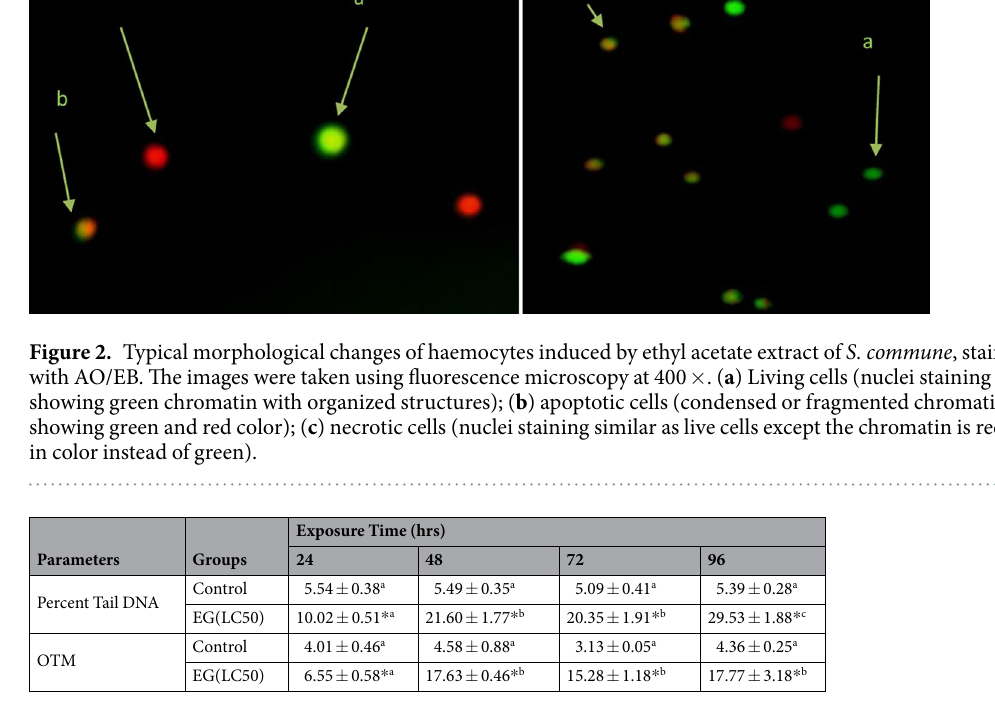
Table 7. Percent Tail DNA and OTM in haemocytes of S. litura after treatment with ethyl acetate extract of S. commune . EG = Exposed group. The values represented as mean ± standard error. * Ascribes the significant difference between exposed group and control group (t-test, p ≤ 0.05). Different letters a, b, c between the columns are significantly different (Tukey’s test, p ≤ 0.05) and signify the effect of